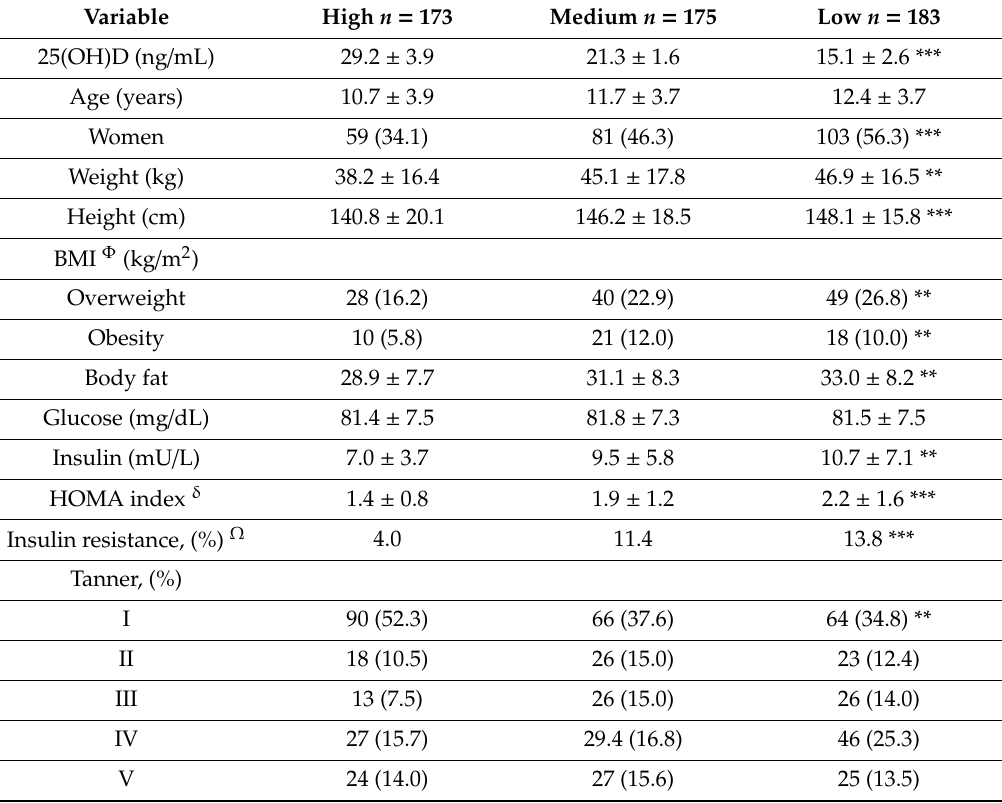
Table 2. Characteristics of the study population, by vitamin D tertile 1